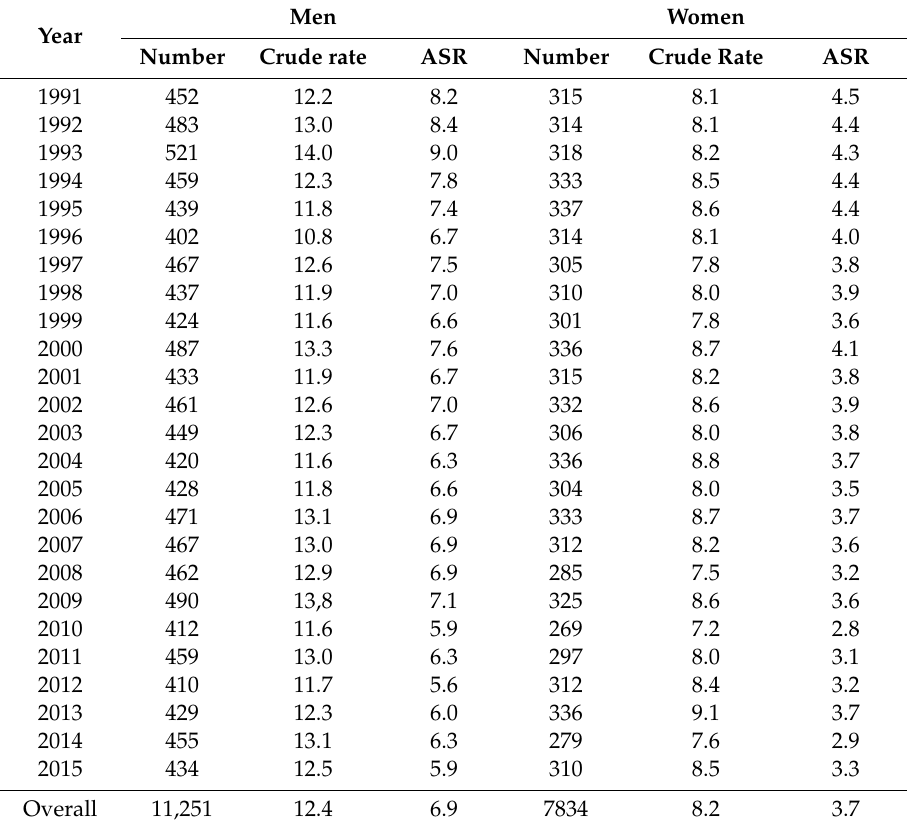
Table 1. Liver cancer mortality in men and women in Serbia, 1991–2018; number of cases, crude rates and age standardized rate (ASR) per 100,000 persons (using World standard population).